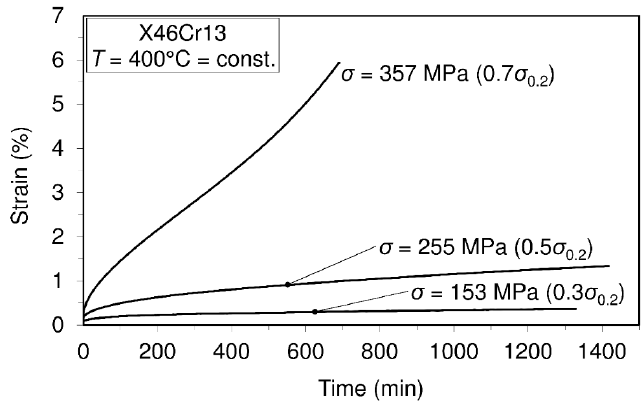
Figure 6. Short-time creep tests of steel X46Cr13 at the temperature of 400 °C.